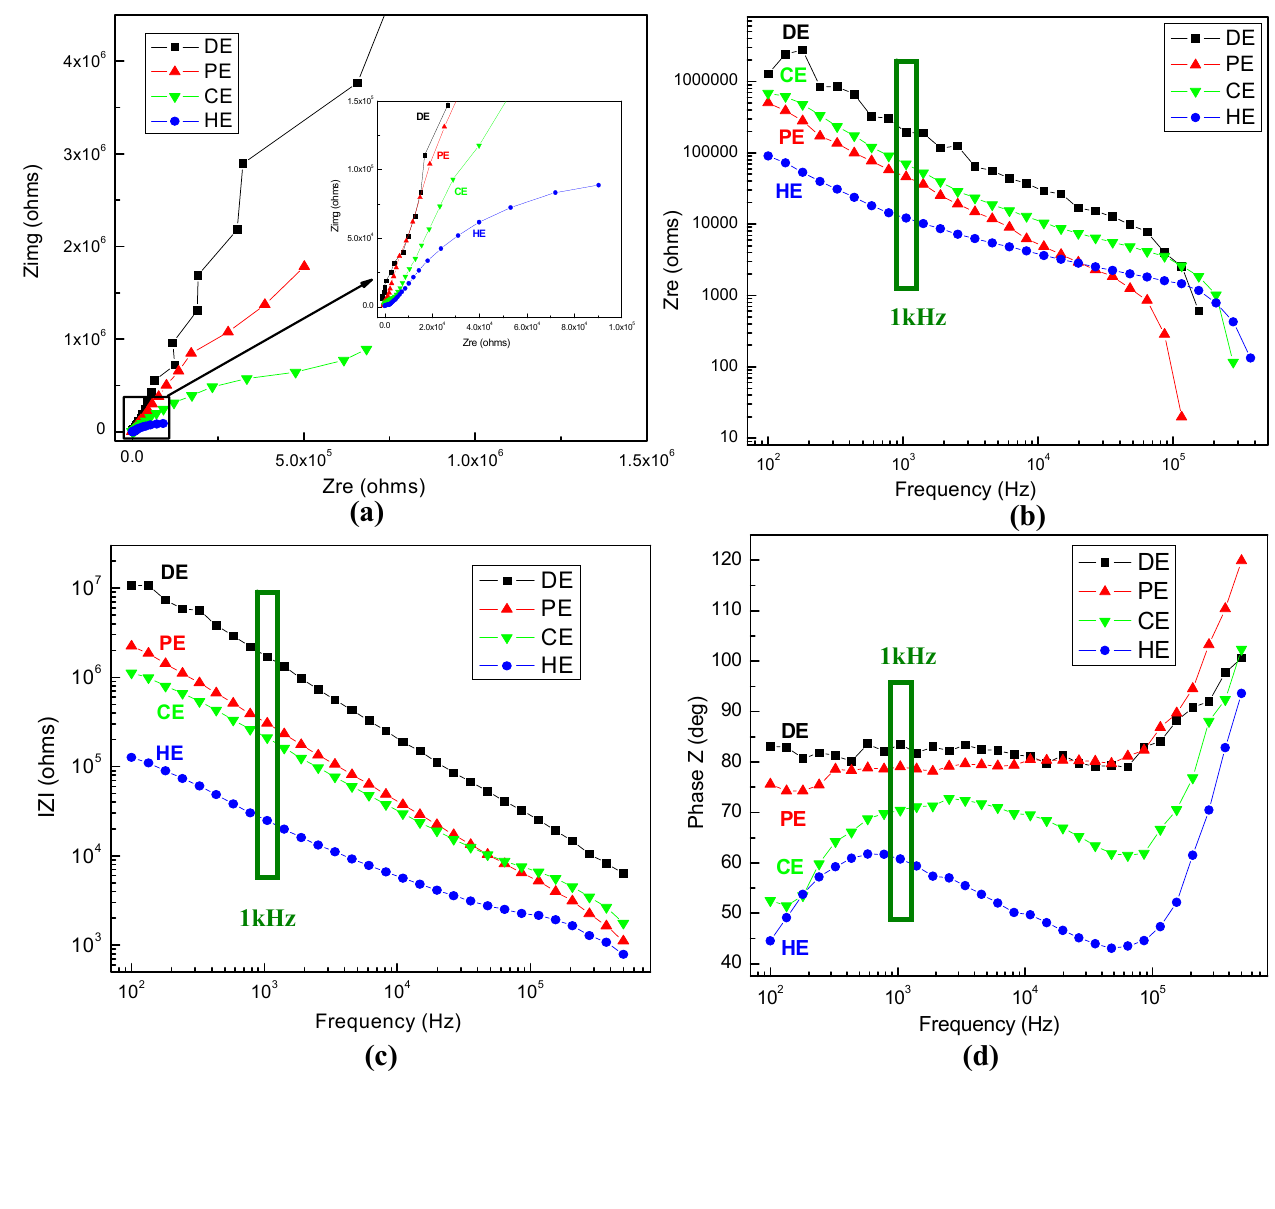
Figure 8. Impedance response of different electrodes— DE , PE , CE , HE —in electrolyte solution of 2mM Fe(CN) 63 − in 0.1 M KCl at OCP: ( a ) complex impedance plane (Nyquist plot); ( b ) real part of the impedance, ( c ) its modulus and ( d ) the phase shift as functions of frequency (Bode